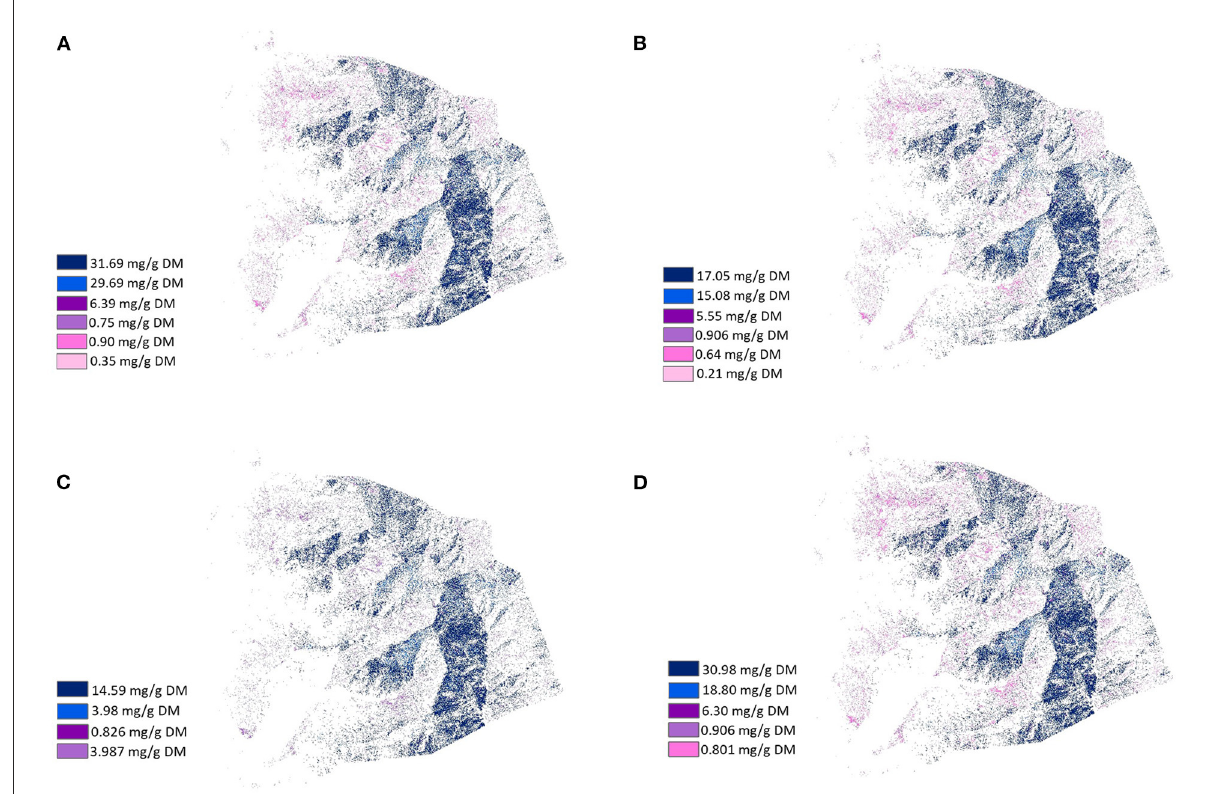
FIGURE4 Healthscape maps presenting the distribution and location of phenolic compounds that have potential medicinal effects according to their concentration in plants (mg/g DM) from LUMGS (Darkest color means the highest concentration). (A) Antioxidant, (B) Antimicrobial, (C) Anti-inflammatory, and (D)